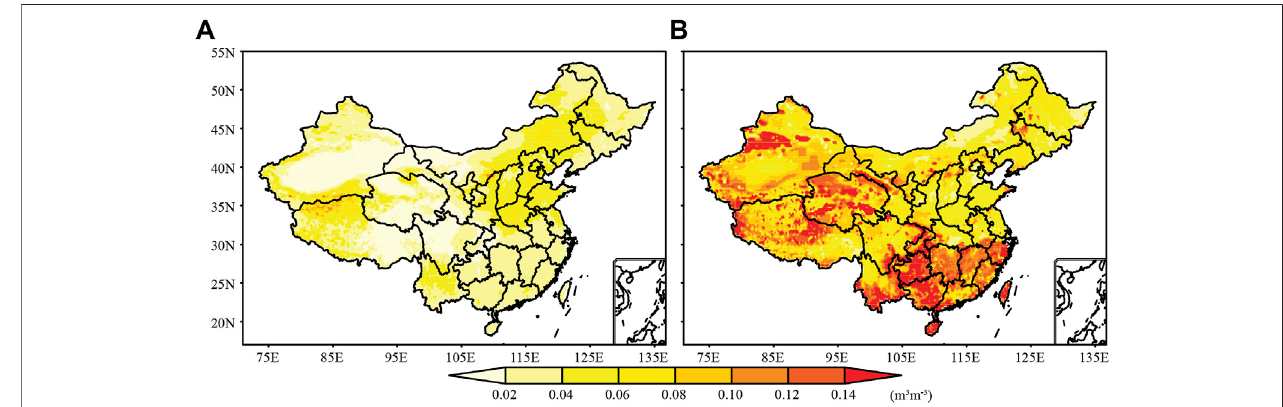
FIGURE 3 | MAE discrepancies of monthly mean SSM in the testing dataset (the period of 2008 – 2014) between (A) CMIP6 DL and ERA5-Land, and (B) ensemble mean and ERA5-Land.